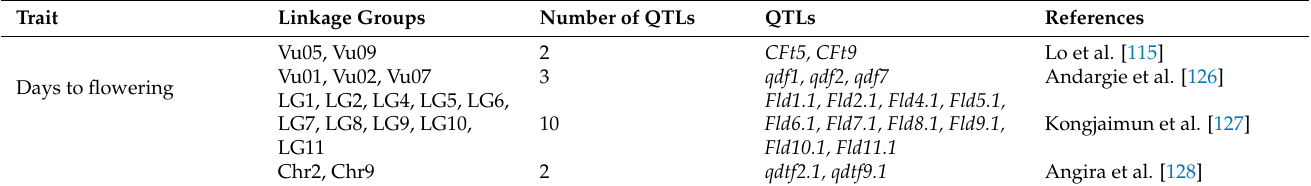
Table 3. Indicative Quantitative trait loci (QTLs) associated with cowpea ( Vigna unguiculata (L.) Walp.) yield and linkage groups to which they